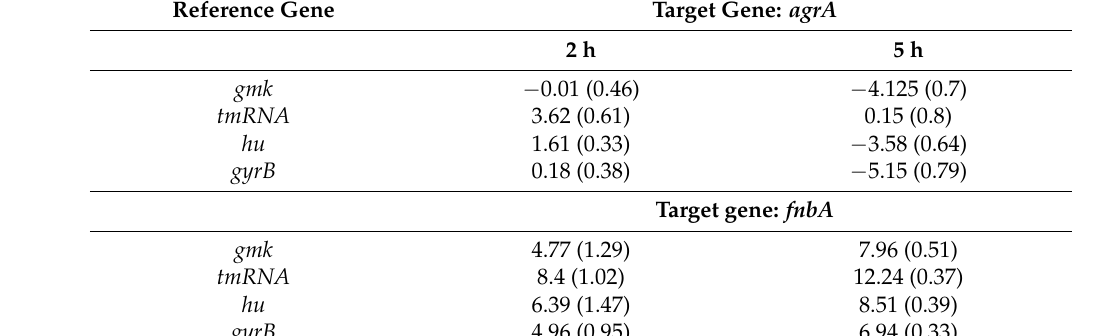
Table 7. Mean and std dev (in brackets) of normalized target gene expression for individual house-